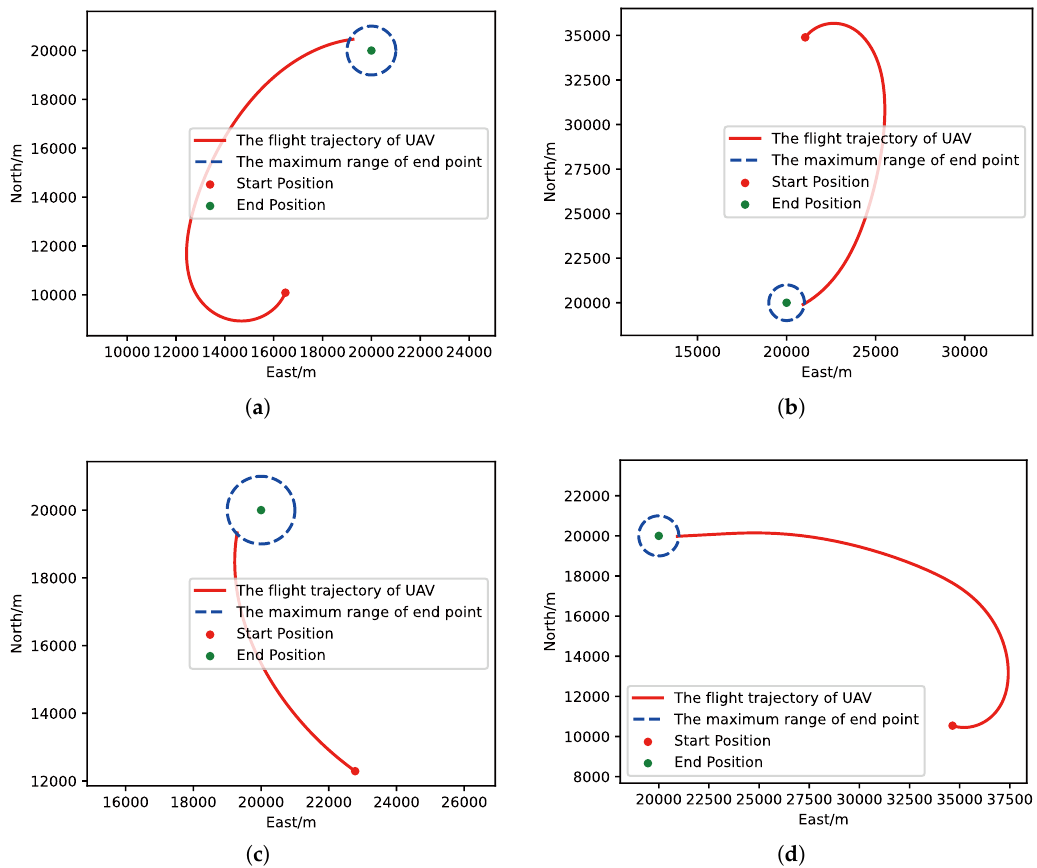
Figure 19. The flight trajectory from MC experiments for the trained result of PER-DDPG: ( a ) The flight trajectory of 1st experiment. ( b ) The flight trajectory of 2nd experiment. ( c ) The flight trajectory of 3rd experiment. ( d ) The flight trajectory of 4th